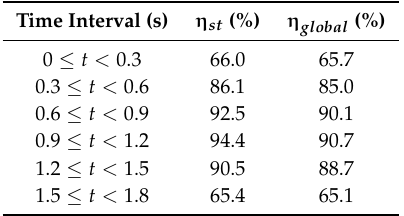
Table 13. Efficiencies calculated in the V2G mode when k = 0.7 k n